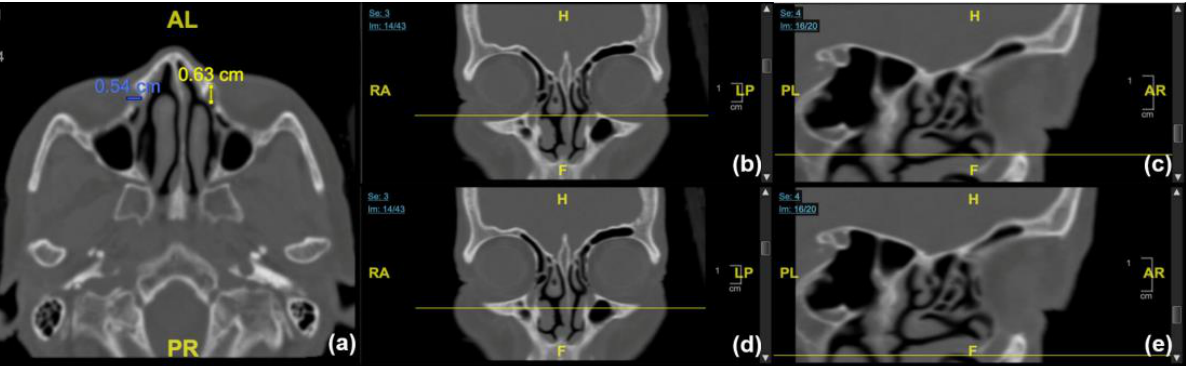
Figure 1. ( a ) Anteroposterior and transverse diameters of the inner bony canal in axial view. The diameters were measured at three levels: the entrance point at inferior orbital margin ( b , c ), the exit point at the opening of inferior meatus ( d , e ), and the minimum transverse diameter along the bony canal.